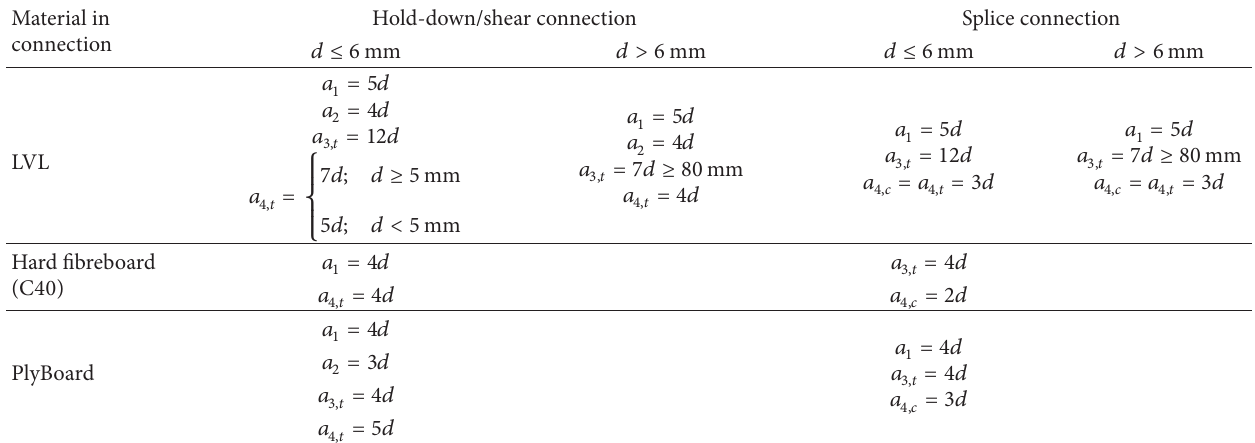
Figure 11: Notations for end and edge distances according to Eurocode 5 [19] for (a) the connection acting as a hold-down (vertical load) and as a shear connection (horizontal load), respectively, and (b) a splice connection between wall elements subjected to a shearing force. Table 4: Recommended minimum values for the end and edge distances shown in Figure 11 with respect to (a) the LVL core as given in [19] for ordinary wood; (b) the hard fibreboard according to [20]; and (c) the PlyBoard panel according to the experimental study presented in Section 4.7. The edge distances for the PlyBoard are estimated because no tests were